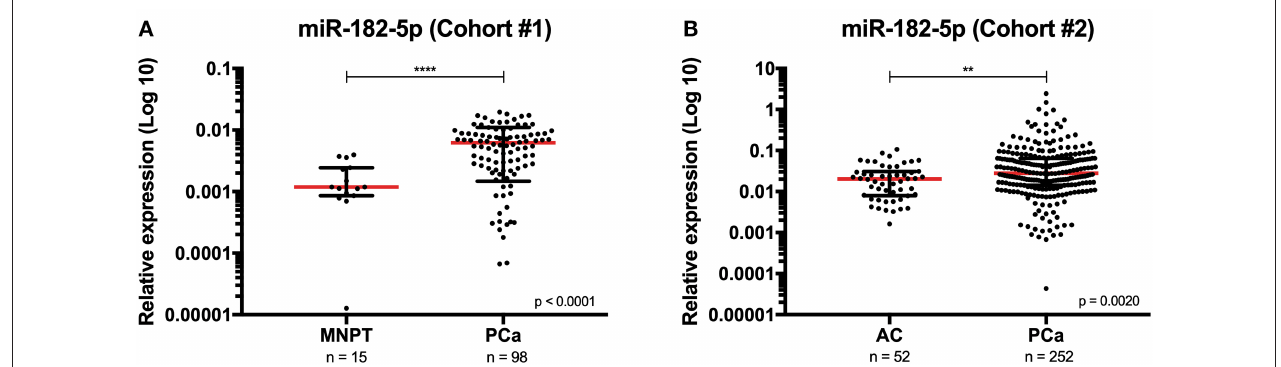
FIGURE 1 | Distribution of miR-182-5p expression levels in Cohort #1 [morphologically normal prostate (MNPT) and prostate cancer (PCa) tissues] (A) , and in Cohort #2 [asymptomatic controls (AC) and PCa patients] (B) . Mann-Whitney U , **** p < 0.0001 and ** p < 0.01. Red horizontal line represents the relative expression levels’ median.